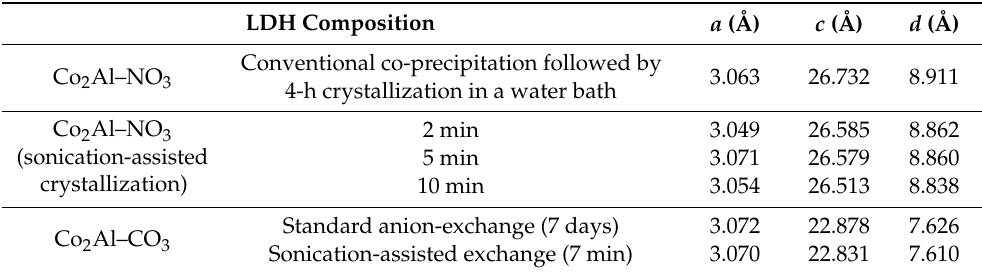
Table Table 1. Lattice parameters ( a , c ) and basal spacings ( d ) of the Co 2 Al LDHs prepared via the conventional co-precipitation synthesis followed by anion-exchange and by means of the sonication- assisted procedures.